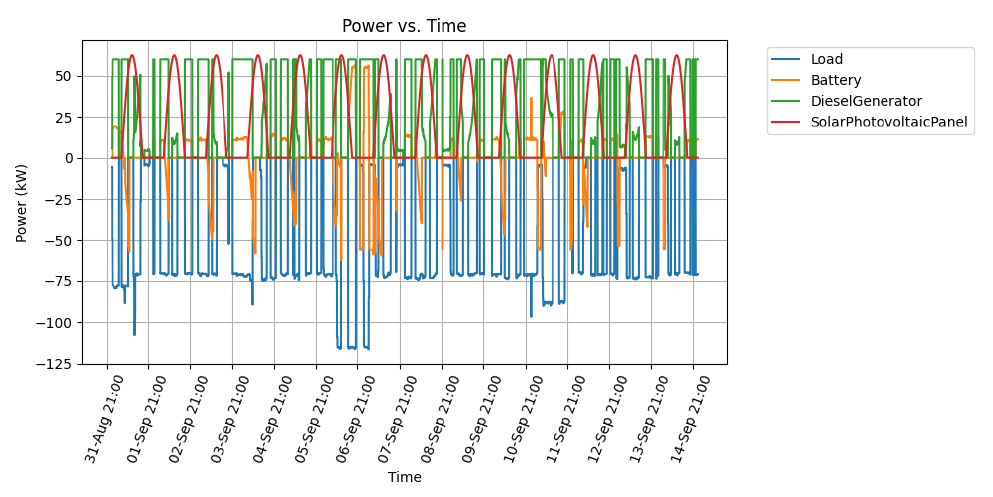
Figure 14. Power profile for a microgrid with 60 kW diesel generation power rating, 81 kW photo- voltaic power rating and 360 kW h BESS. ·